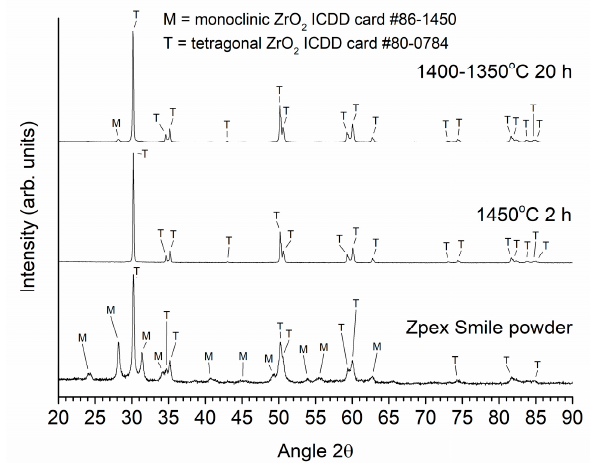
Figure 12. XRD patterns of the Zpex Smile powder, a conventionally sintered sample and a two-step sintered sample (T1 = 1400 °C, T2 = 1350 °C, t2 = 20 h). All samples prepared from as-received powder.